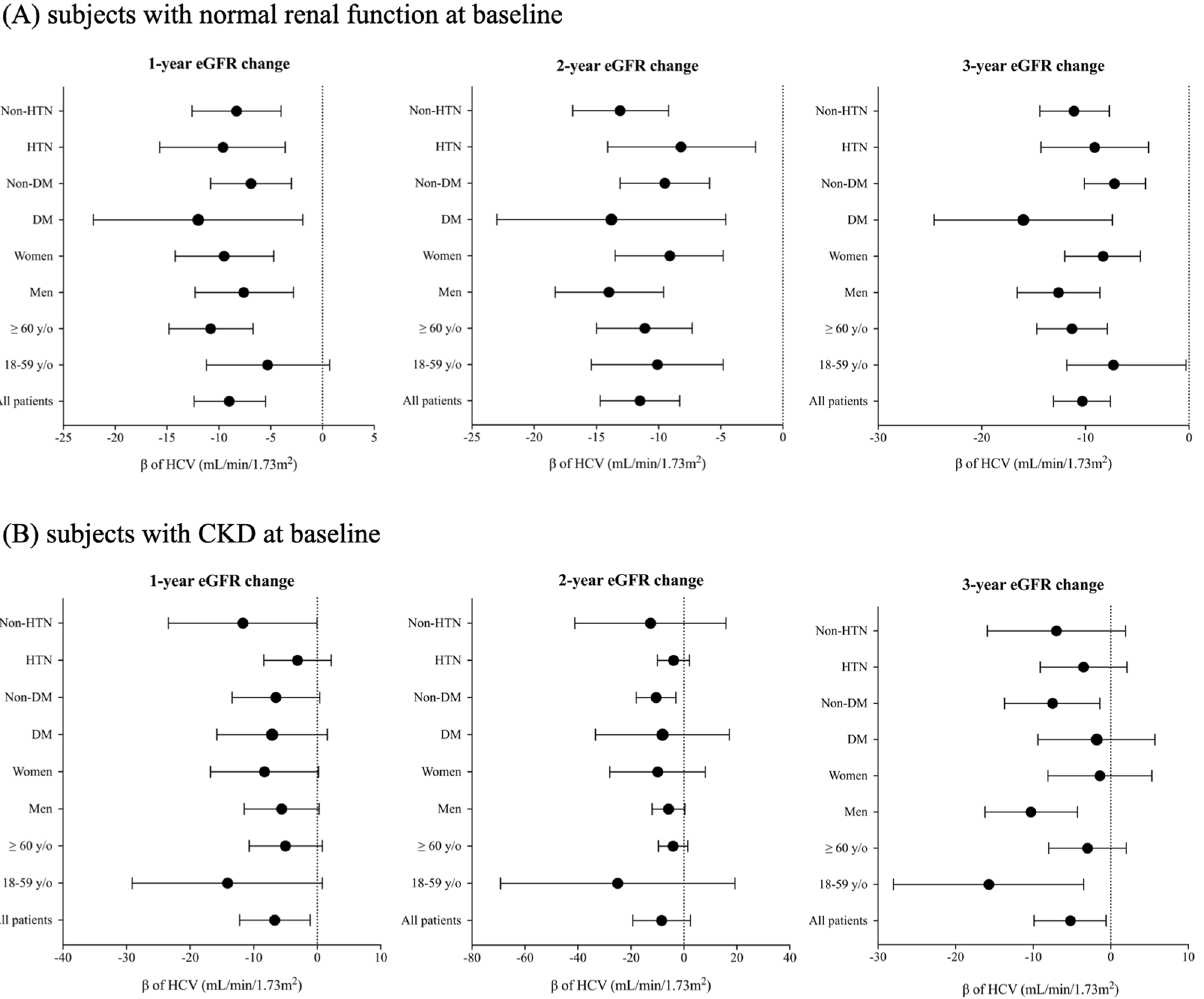
Figure 3. Unstandartized coefficients of HCV in a linear regression model for annual eGFR decline in subjects with normal function at baseline ( A ) and patients with CKD at baseline ( B ). CKD, chronic kidney disease; DM, diabetes mellitus; eGFR, estimated glomerular filtration rate; HCV, hepatitis C virus infection; HTN,